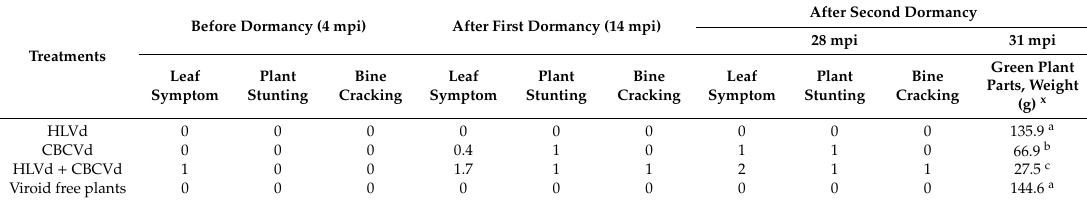
Table 1. Infectivity assessment of hop plants (cv. Celeia) following biolistic inoculation of HLVd, CBCVd and HLVd + CBCVd.